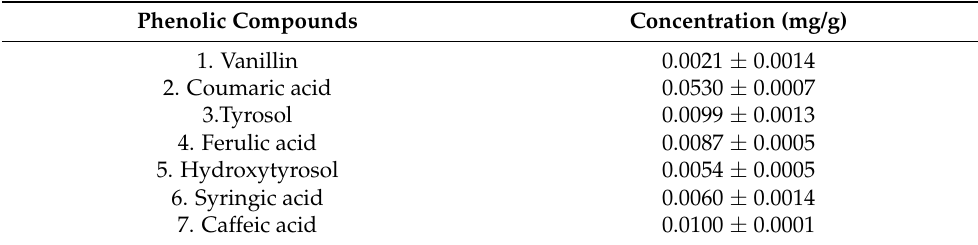
Figure 6. HPLC-DAD chromatograms of phenolic compounds extracted under optimal operating parameters. Peak numbers: 1. vanillin, 2. coumaric acid, 3. tyrosol, 4. ferulic acid, 5. hydroxytyrosol, 6. syringic acid, 7. caffeic acid, 8. ellagic acid, 9. hesperidin, 10. epicatechin, 11. catechin, 12. apigenin, 13. cinnamic acid, 14. rosmarinic acid, 15. rutin, 16. naringin, 17. quercetin, 18. pinoresinol, 18 ′ . pinoresinol acetone, 19. kaempferol, 20. luteolin, mAU (milli-absorbance unit). Table 5. Quantification of phenolic compounds obtained under optimal BBD